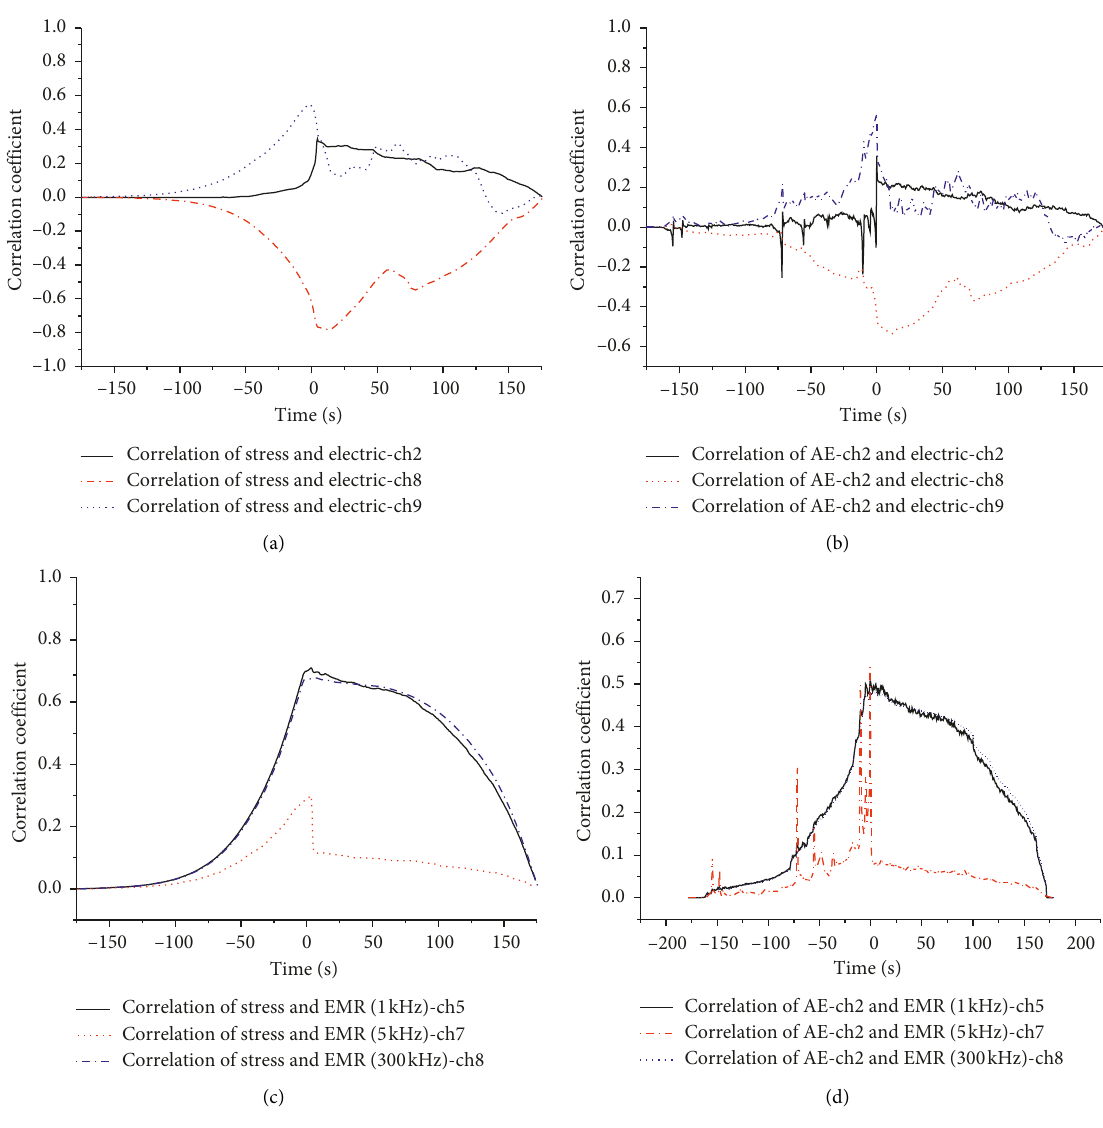
Figure 7: Correlation coefficient of signals (sample 1). (a) Stress vs. electric signals. (b) AE energy vs. electric signals. (c) Stress vs. EMR energy. (d) AE energy vs. EMR